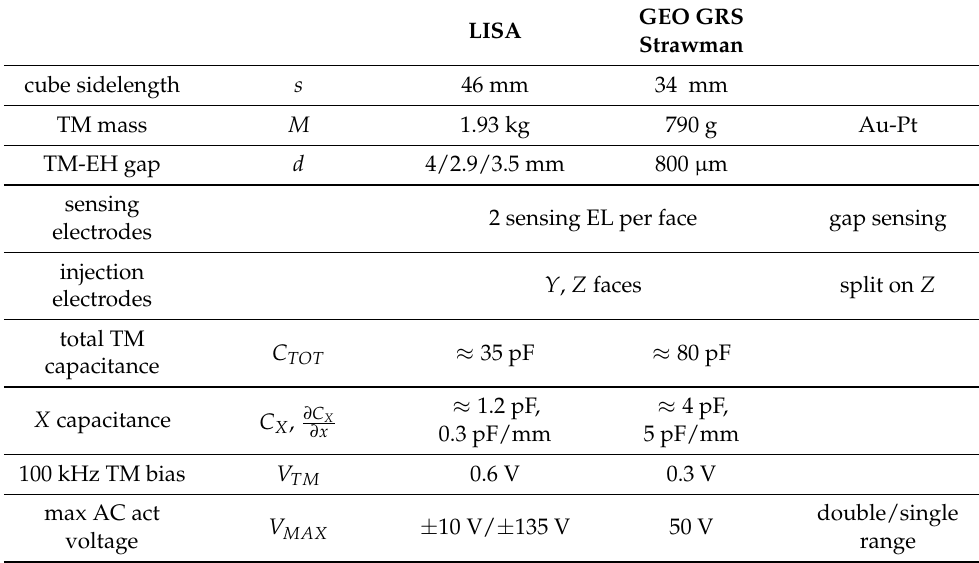
Table 1. Comparison of “strawman” geodesy GRS considered here with the LPF GRS design, for key TM/EH/electronics design